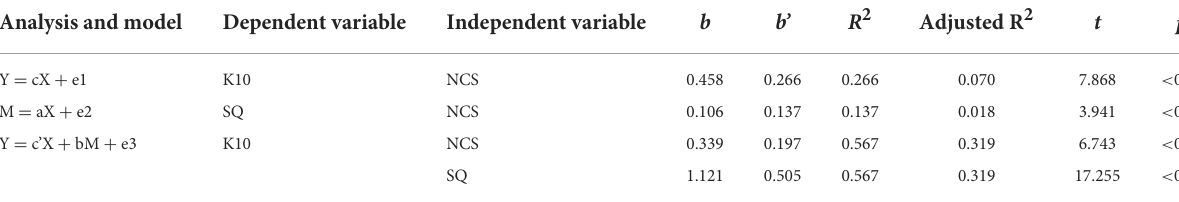
TABLE 5 Stratified regression models for sleep quality, negative coping style and psychological distress among psychiatric nurses ( n = 812, Shandong, China). Analysis and model